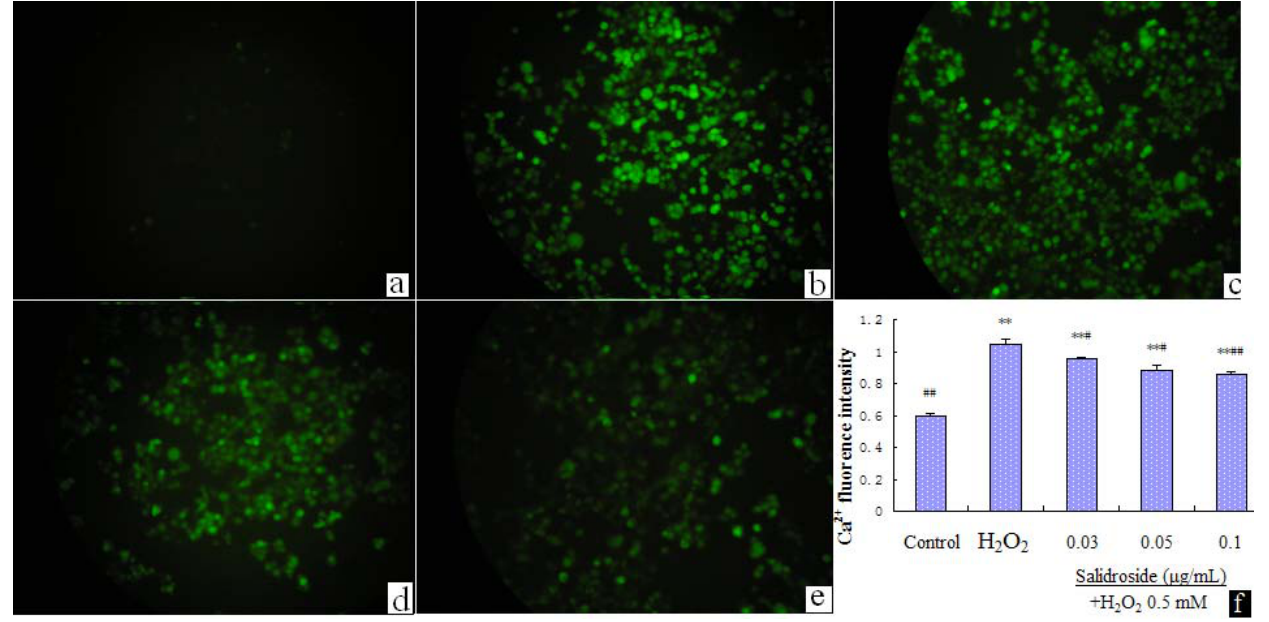
Figure 3. Salidroside inhibited H O -induced [Ca 2+ ]i elevation (Recorded by inverted 2 2 fluorescence microscope, Motic AE31 200×). ( a ). Control; ( b ). H O ; ( c ). 0.03 μ g/mL 2 2 O ; ( d ). 0.05 μ g/mL salidroside + H O ; ( e ). 0.1 μ g/mL salidroside + H O ; salidroside + H 2 2 2 2 2 2 ( f ). Statistical analysis of fluorescence intensity data with Motic Advanced Images 3.2 software (China). Cells were treated with salidroside followed by H O as described in 2.2. 2 2 and [Ca 2+ ]i levels were determined with Fluo-3/AM fluorescent